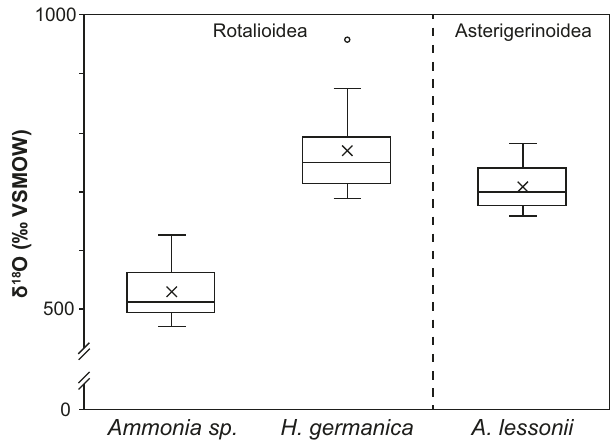
Fig. 3 Bulk 18 O-enrichment after incubation. Box plot distributions of bulk 18 O-enrichment in tests of the three benthic foraminifera species incubated for 6 days at 90 °C in seawater analogue with a 18 O/ 16 O ratio of 0.30. The average 18 O-enrichments are shown with crosses. The superfamily that the foraminifera species belong to are indicated at the top of the fi gure. Middle lines = medians, boxes = interquartile ranges, whiskers = minimum and maximum values, empty circle =